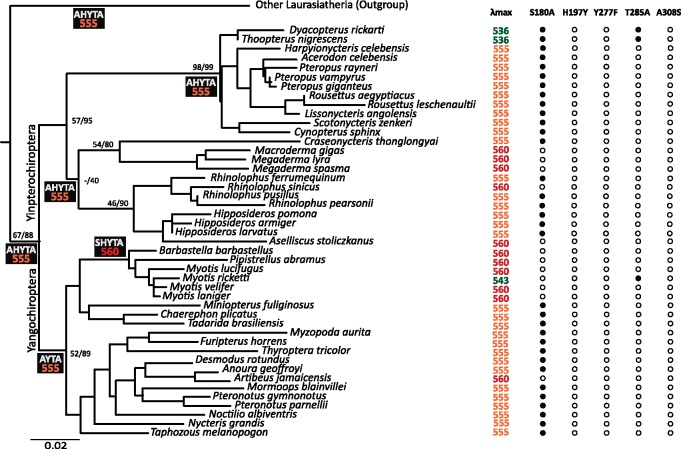
Ancestral state reconstruction spectral tuning sites and inferred λmax of the MWS/LWS opsin gene for major bat clades. Inferred λmax values are shown for each species in addition to the observed changes in the five MWS/LWS spectral sites for each species. The spectral sites for the MWS/LWS opsin and estimated λmax for the laurasiatherian ancestor is based on Liu et al. (2018).